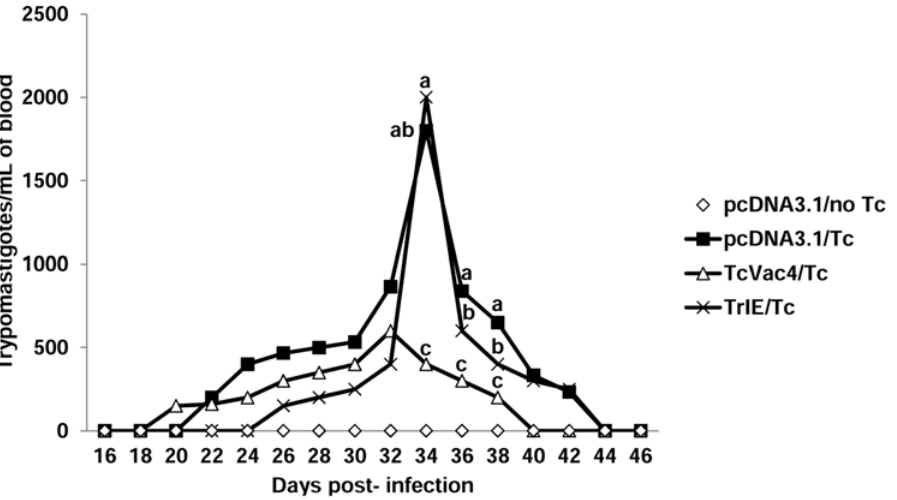
Fig 2. Blood parasitemia control in dogs immunized with TcVac4. Dogs were immunized with TcVac4 or TrIE, and infected with T . cruzi as in Fig 1. Blood samples were evaluated for parasitemia by light microscopy at alternate days post-infection. Shown are data from day 16 to 46 after challenge infection, presented as mean values (n = 6/group). Different letters above lines show statistical differences (p < 0.05) among treatments within the same day of sampling according to Tukey ’ s